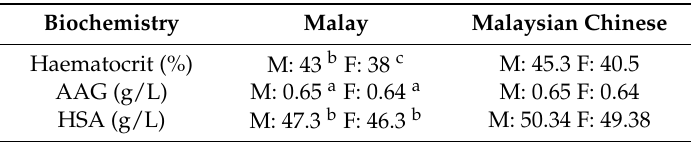
Table 3. Malay and Malaysian Chinese blood biochemistry.